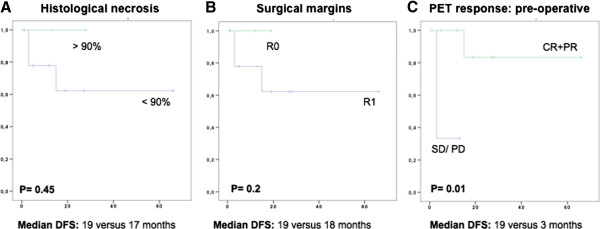
Disease-free survival in patients with craniofacial bone sarcomas. Kaplan Meier curves demonstrating disease-free survival in patients with craniofacial cone sarcomas according to histological necrosis (A), status of resection margins (B) and preoperative 18FDG PET/CT (C) response.